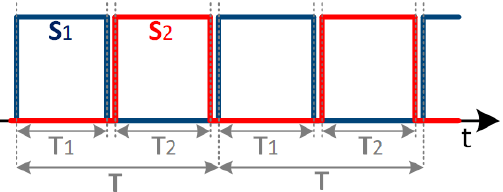
Figure 3. Control signals for the semiconductors S 1 and S 2 during two periods.